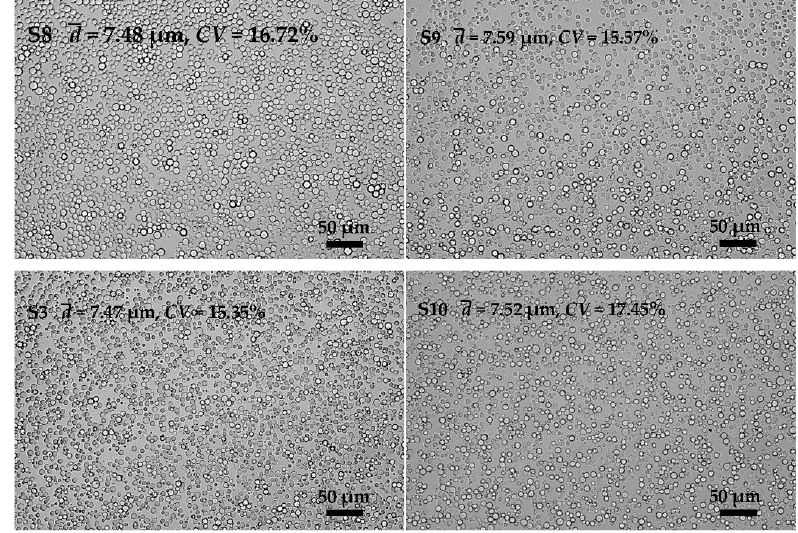
Figure 7. Microscopic photographs of KGM emulsions prepared with different oil phase compositions